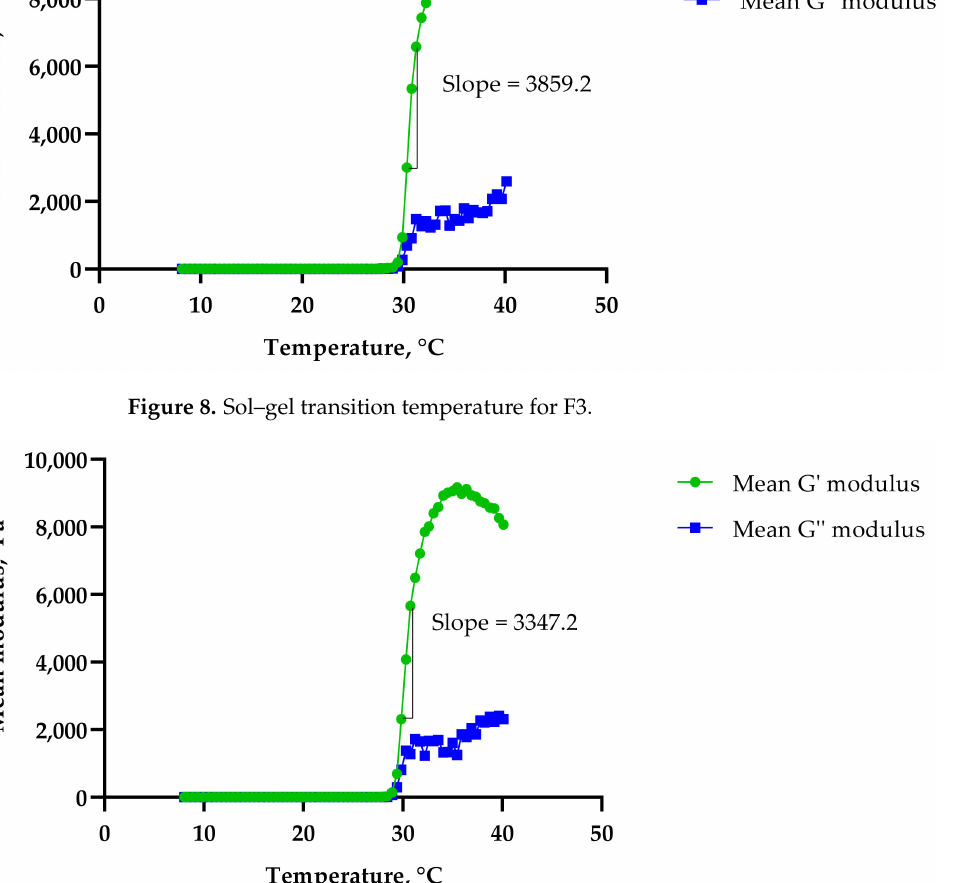
Figure 9. Sol–gel transition temperature for